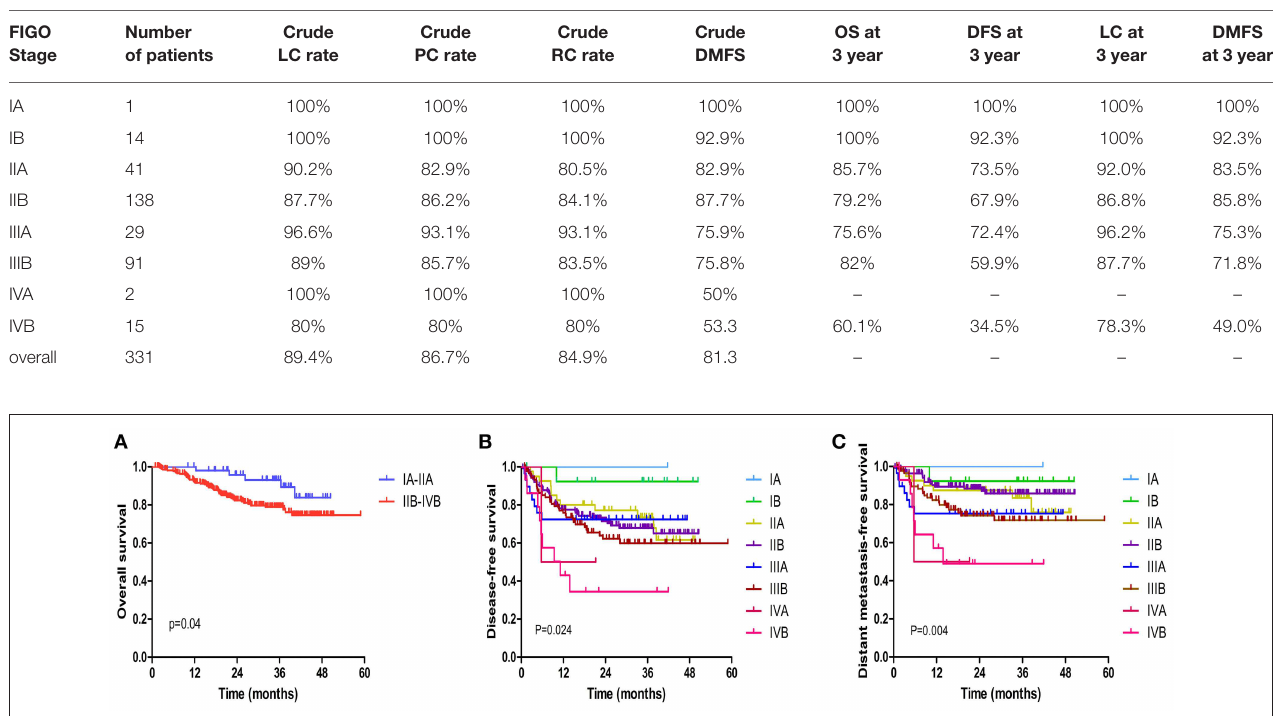
TABLE 3 | Clinical outcomes at 3 years according to stages in VAMT group patients. FIGO Number Stage of patients